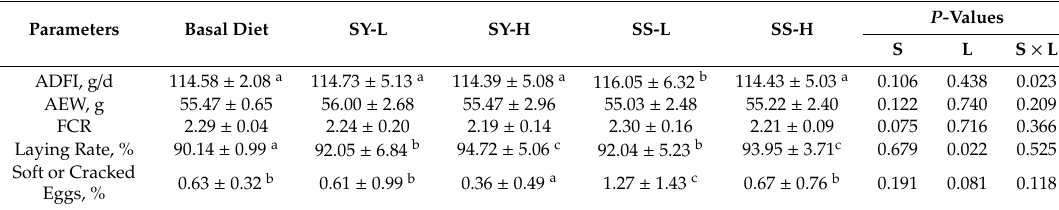
Table 2. E ff ects of dietary supplementation of di ff erent selenium sources and levels on production performance of laying hens.